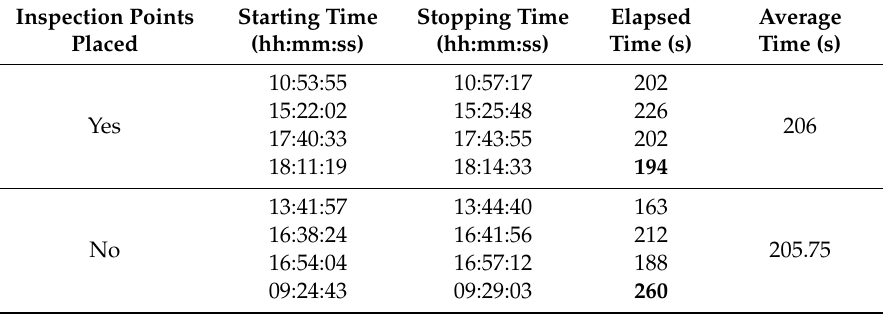
Table 1. The patrol time comparison of each experiment.